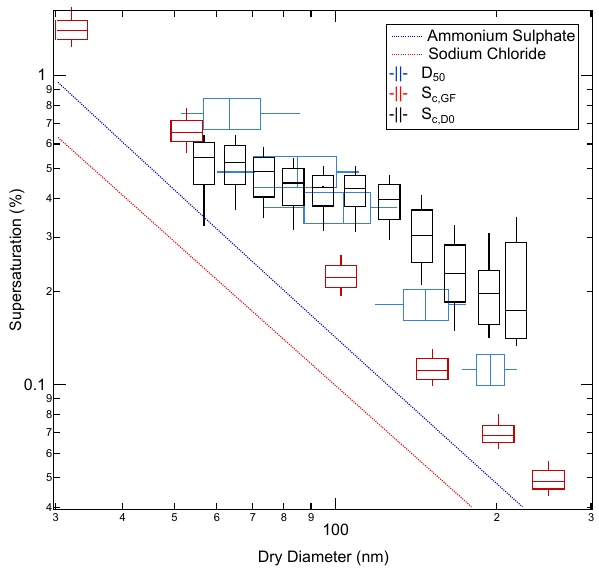
Fig. 7. Critical supersaturation vs. dry diameter for the HTDMA re- sults predicted using the κ model, CCNc results using both derived S c , D0 and derived D 50 , S . The centreline of the box represents the median of the data, with the box edges representing the 25% and 75% quartiles and the whiskers the 10% and 90% quartiles. The dashed lines show the results of the ADDEM model (Topping et al., 2005) for inorganic salt